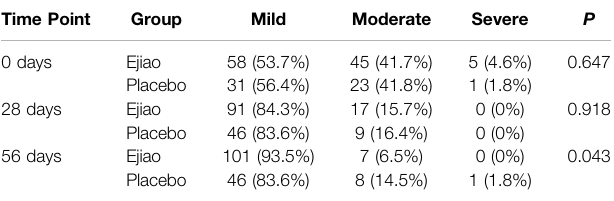
TABLE 2 | The symptom of dizziness after administration of Ejiao for 8 weeks.